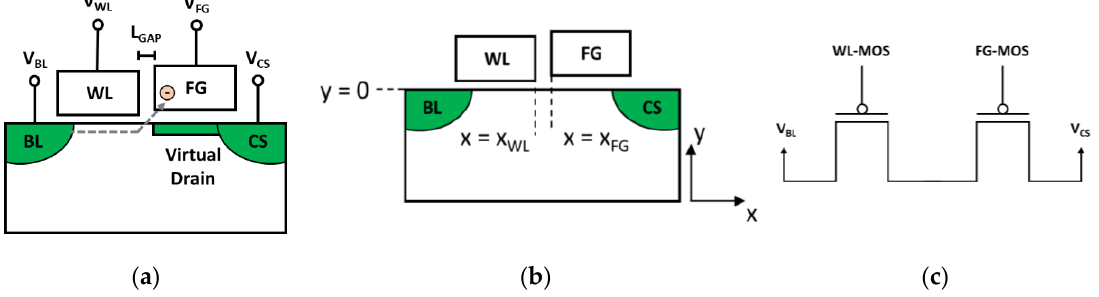
Figure 1. ( a ) The SuperFlash cell structure, with the source side injection (SSI) mechanism sketched; ( b ) adopted frame of reference definition; ( c ) approximation with the series of two transistors: WL-MOS and FG-MOS.